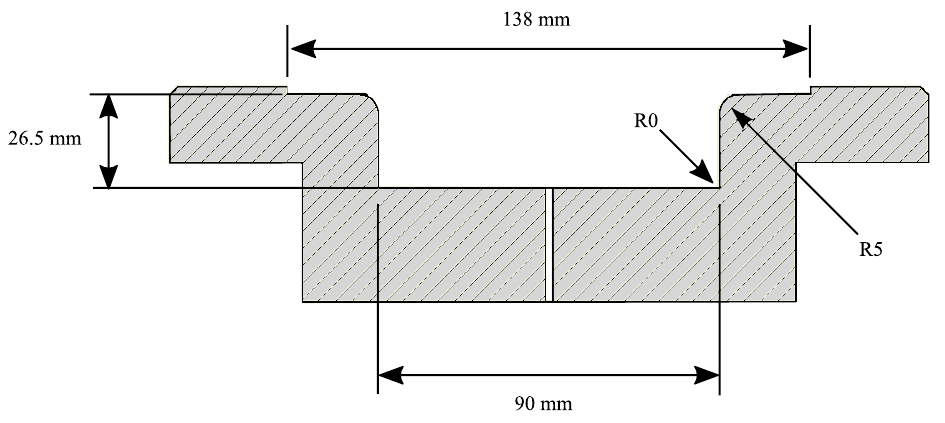
Figure 2. Dimensions of the die.